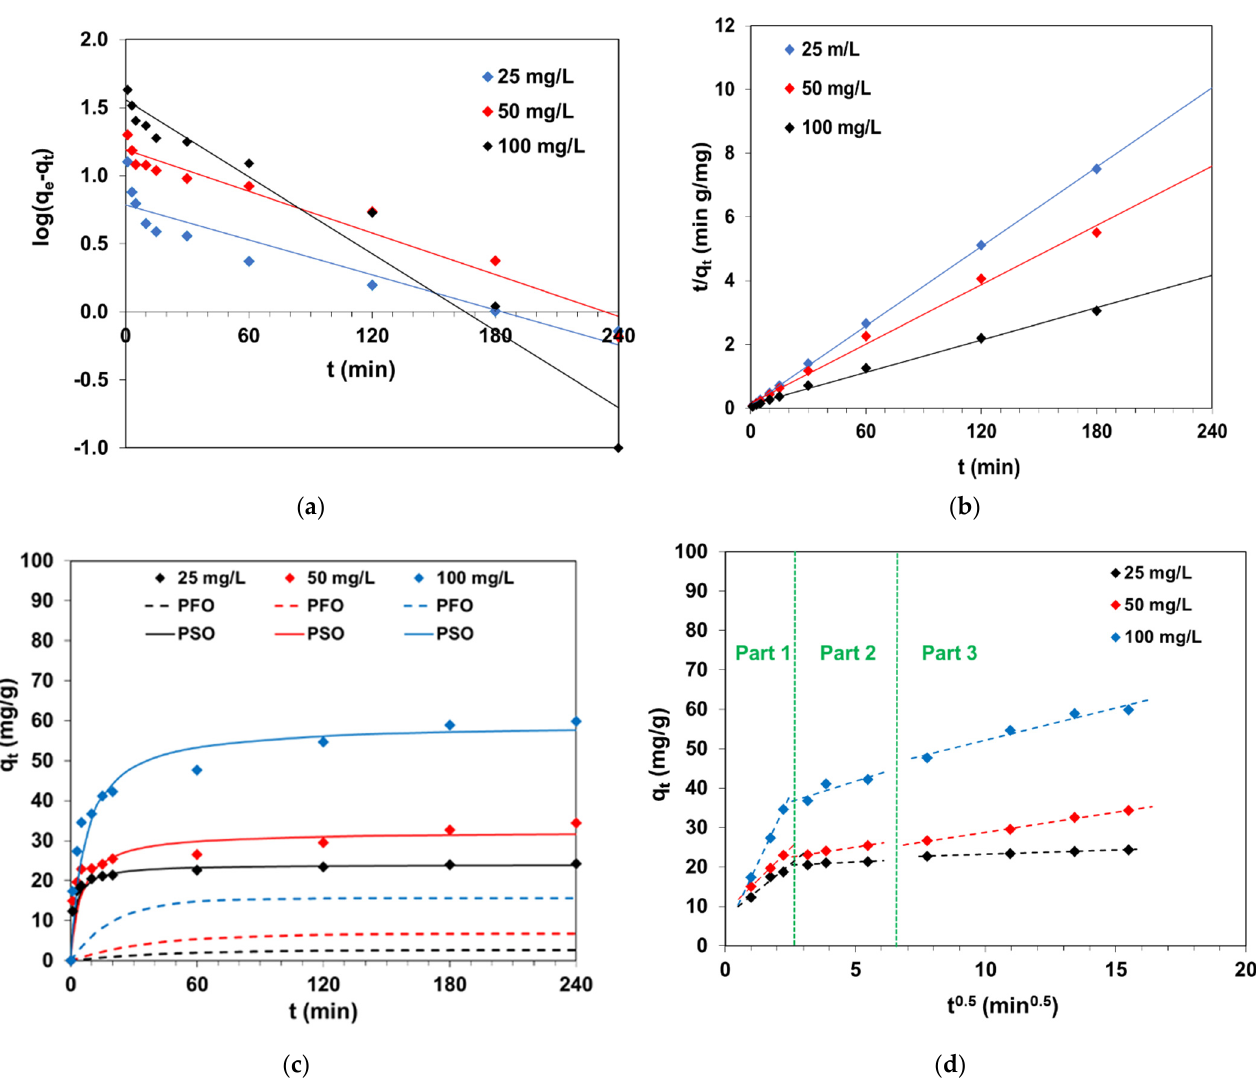
Figure 4. ( a ) PFO and ( b ) PSO kinetic plots, ( c ) fitting curves of experimental data to PFO and PSO models and ( d ) intraparticle diffusion graph in the BR46–C/SiO 2 system. One can see that BR46 adsorption on C/SiO 2 obeys the pseudo-second-order model. This is confirmed by the linear plot t / q t vs. t and the largest determination coefficients R 2 being in range of 0.996–0.999 depending on the dye concentration. The q e values calculated on the basis of the PSO model (24.1 mg/g, 32.2 mg/g and 59.2 mg/g for the solutions containing 25 mg/L, 50 mg/L and 100 mg/L of BR46, respectively) are similar to the values determined experimentally q e,exp (25.0 mg/g, 34.5 mg/g and 60.0 mg/g), which, apart from the values of the determination coefficients R 2 (Table 3), confirmed its use in the kinetic description of the tested systems. The rate constants k 2 drop with increasing BR46 content in the solution. It is believed that at higher concentrations, the initial adsorption leads to swelling of the adsorbent, thus exposing the inner surface and pores for greater adsorption. This part of the process is likely to be slower due to diffusion of this large molecule to this hidden surface in the pores of the adsorbent [35].